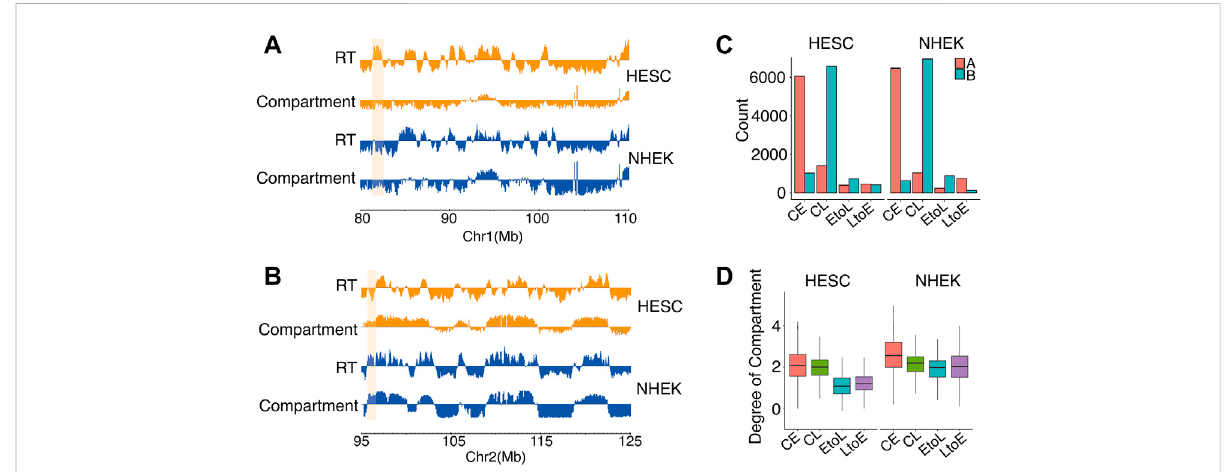
FIGURE 3 Subnuclear compartment compositions ofthefour RDcategoriesin hESCs and NHEK cells. (A,B) Twoexamples showing discordance between RT and A/B compartments. The region highlighted in orange shows EtoL in the B compartment in both cell types (A) . Region highlighted in orange showsLtoEintheAcompartmentinbothcelltypes (B) . (C) CompartmentcompositionsofCE,CL,EtoL,andLtoEinhESCandNHEKcells. (D) Degrees of compartmentalization of CE, CL, EtoL,and LtoE in hESC and NHEK cells. p values are calculated using the Wilcoxon rank-sum test. ***p < 1e-3.